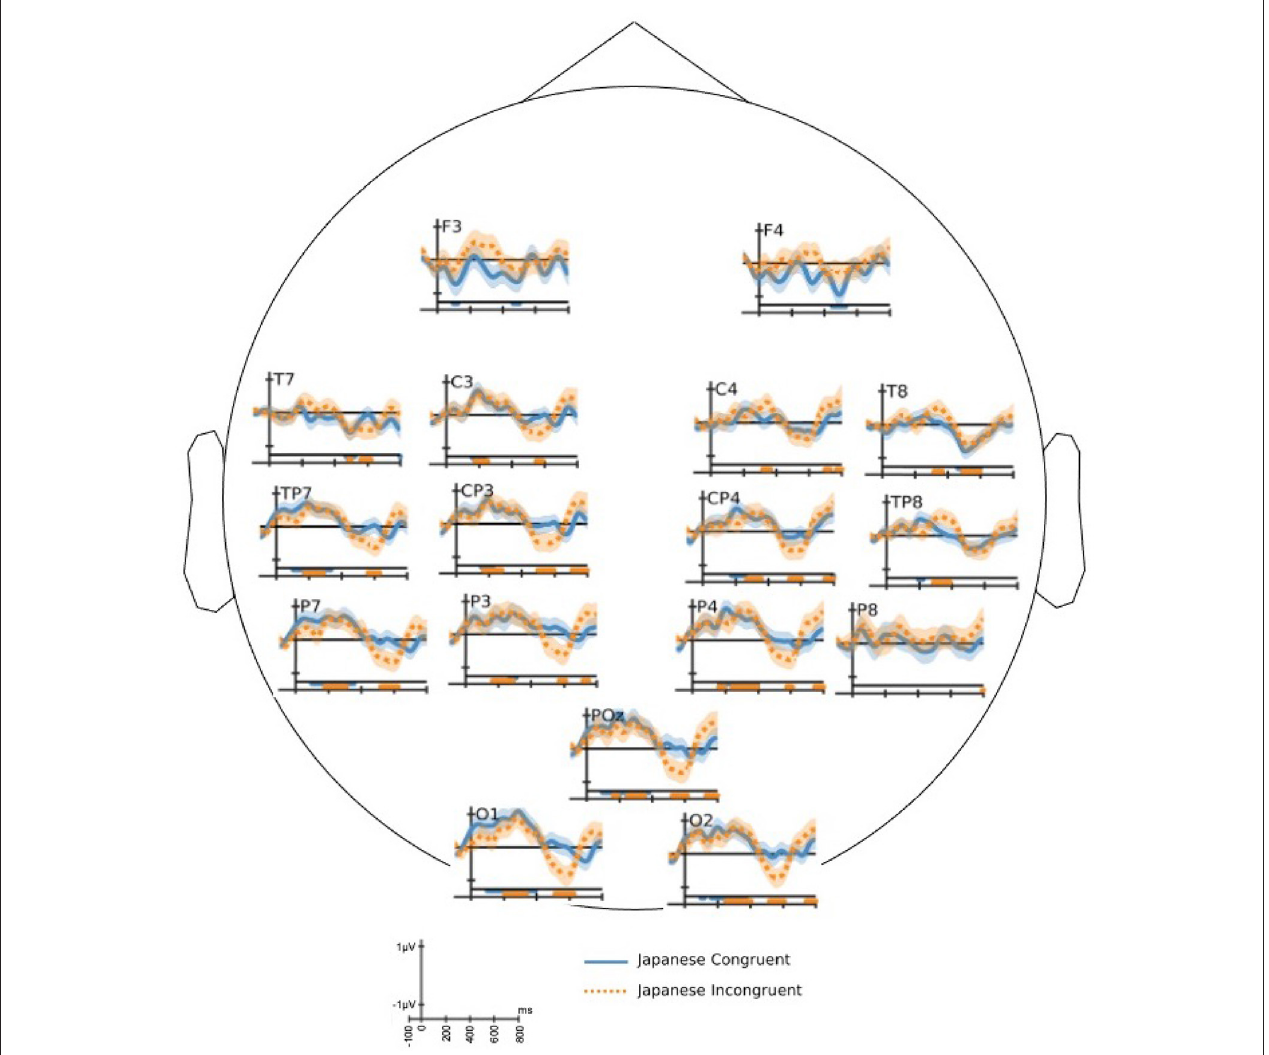
FIGURE 5 | Grand average difference event-related potential (ERP) response of Japanese Congruent end-word from Japanese end-word response before learning its meaning (solid), and Japanese in-congruent end-word from Japanese end-word response before learning its meaning (dotted). The horizontal bars drawn in the bottom of each plot signify the time regions with significant (two-sample t -test with p < 0.05) difference in the ERP response. The bars have the same color of the associated difference waveform.